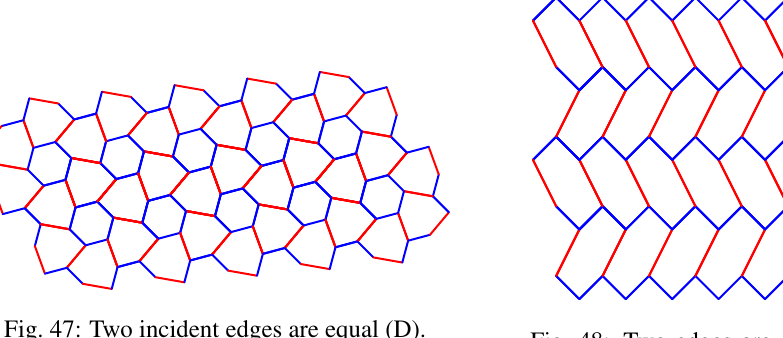
Fig. 48: Two edges are of equal length. This allows using reflected coronae with respect to the case in Figure